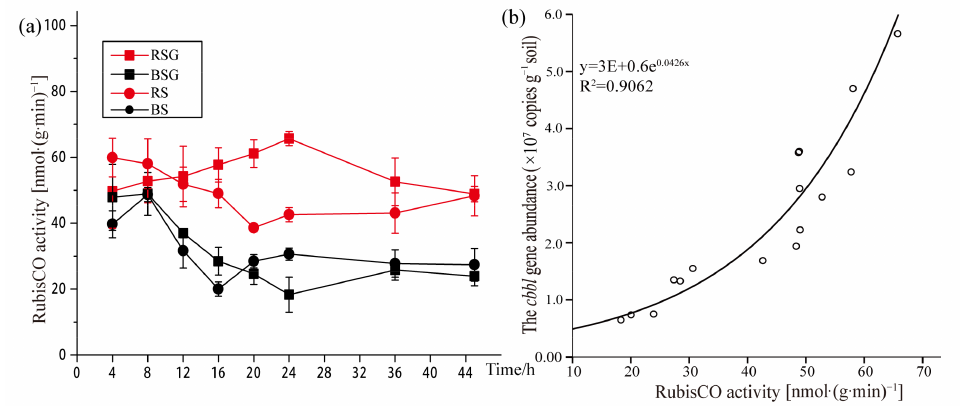
Figure 5. ( a ) Changes of RubisCO (ribulose-1,5-biphosphate carboxylase/oxygenase) activity and ( b ) the power function curves between cbbL gene abundance and RubisCO activity based on the cbbL gene abundance at the 8th, 16th, 24th, and 45th h of glucose degradation in the four